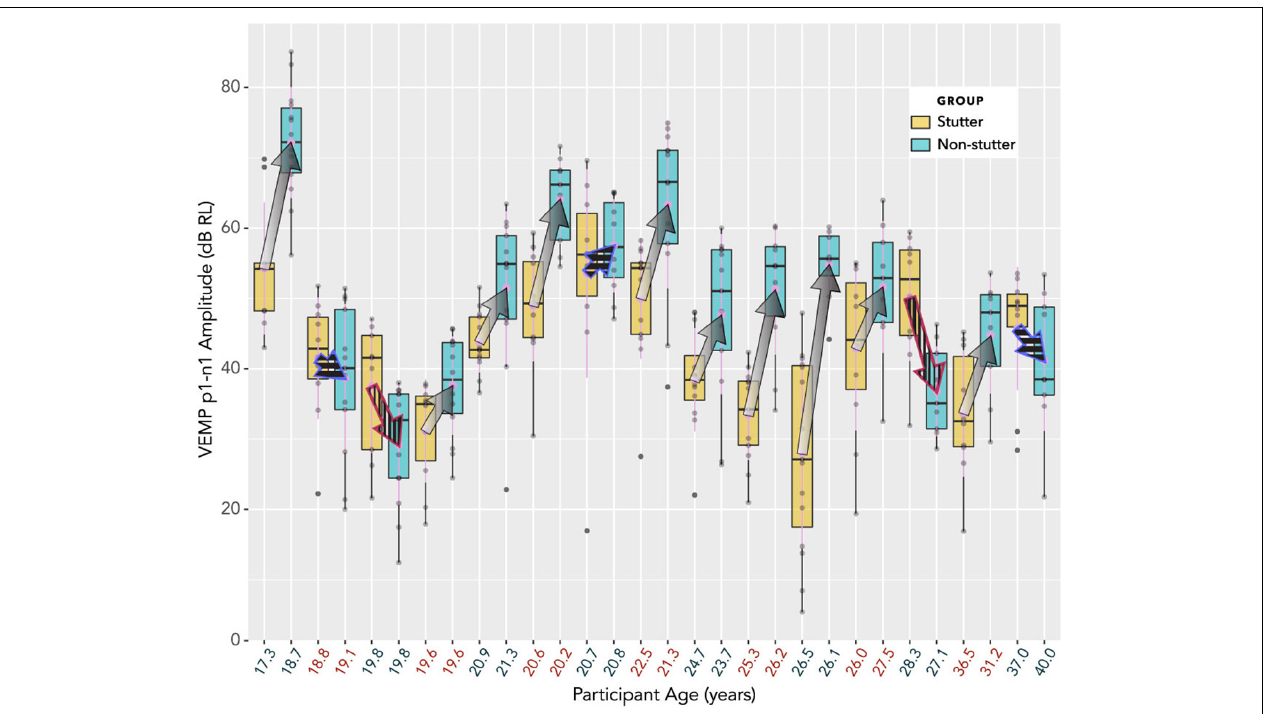
FIGURE 8 | Box plots showing distributions of VEMP p1-n1 amplitude, with participants who stutter and paired non-stutter control participants arranged adjacently in order of age. The box plot does not show detail of stimulus level (although, larger VEMP p1-n1 amplitude almost invariably corresponds to higher stimulus level). Log transformation on the ordinate is such that a 6 dB increase corresponds to a doubling of the VEMP p1-n1 amplitude in normalised microvolts (i.e., with unity RMS background). Arrows link the mean VEMP p1-n1 amplitudes of participants who stutter with those of their paired controls. The control participant without stuttering is always shown at the point of the arrow, whilst the participant with stuttering is where fletching would appear. In 10 cases (arrows with gradients) VEMP p1-n1 amplitudes are overall markedly higher for non-stutter than stutter participants. In three cases (blue outline arrows with horizontal stripes) there is a partial overlap, which will be evaluated in the statistical analysis. In two cases (red outline arrows with vertical stripes) VEMP p1-n1 amplitudes are overall clearly higher for the stutter than the non-stutter participants. These two participants who stutter differed from the remaining 13 in the stutter group (one had a possible psychogenic onset, the other had both cluttering and stuttering). All 15 participants in the stutter group, along with the 15 control participants in the non-stutter group, were included in the linear mixed-effects regression